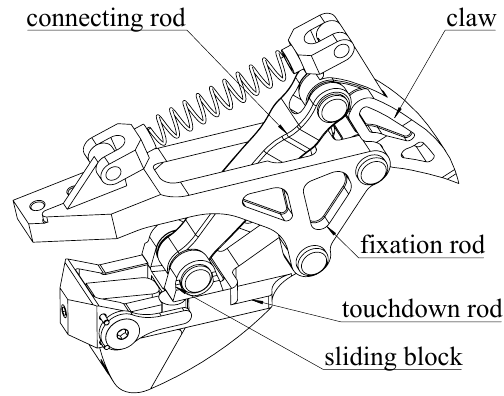
Figure 4. The bionic mechanism on the foot.